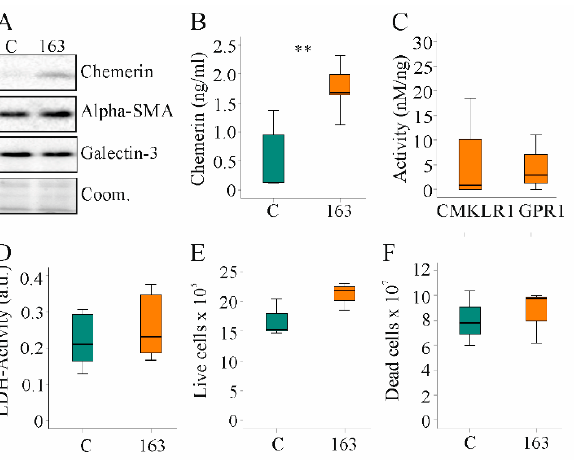
Figure 6. Overexpression of huChem-163 in human LX-2 cells: ( A ) Immunoblot of chemerin, alpha-smooth muscle actin (alpha-SMA), and galectin-3 in LX-2 cells overexpressing huChem-163; ( B ) Chemerin in the supernatant of these cells ( n = 4); ( C ) Activation of human chemokine-like receptor 1 (CMKLR1) and human G protein-coupled receptor 1 (GPR1) by the media of the recombinant cells relative to total cell media chemerin. Control-transfected cell supernatant was not active, and overexpression of huChem-163 did not significantly increase CMKLR1 or GPR1 activity ( n = 4); ( D ) Lactate dehydrogenase (LDH) activity ( n = 4; arbitrary units: a.u.); ( E ) Number of live cells ( n = 3); ( F ) Number of dead cells ( n = 3). Student’s t -test, ** p < 0.01.